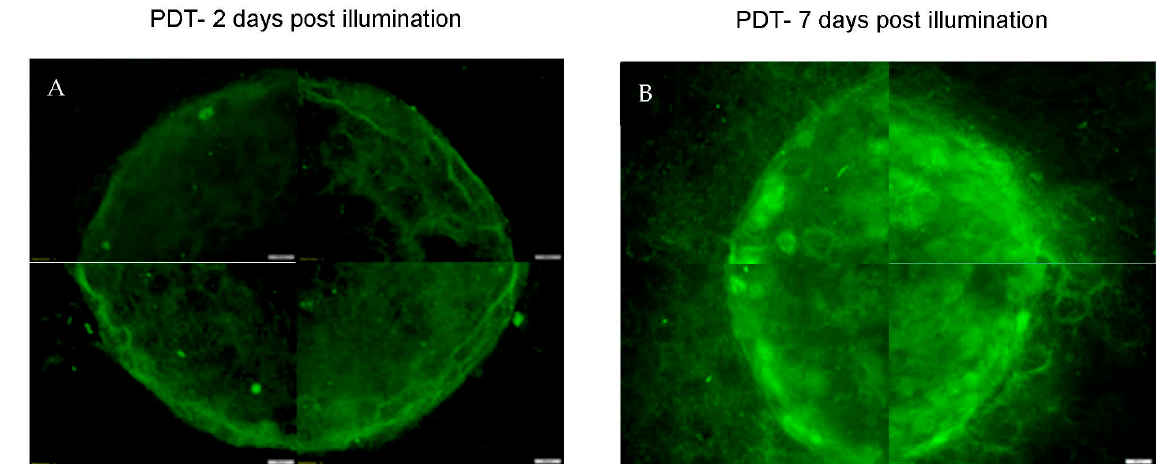
Figure 7. Regrowth of cancer cells in PDT-treated simple tumouroid 7 days post-treatment. The tumouroid was treated with TPPS 2a (0.5 μ g/mL) and 3 min of light illumination. ( A ) Image of a tumouroid 2 days post light illumination; ( B ) Image of a tumouroid 7 days post light illumination. The cells were stained with anti-cytokeratin 7 (Alexa Fluor 488) 𝜆 Ex/Em : 490/525 (green) conjugated antibody. The scale bar presented is 200 μ m.